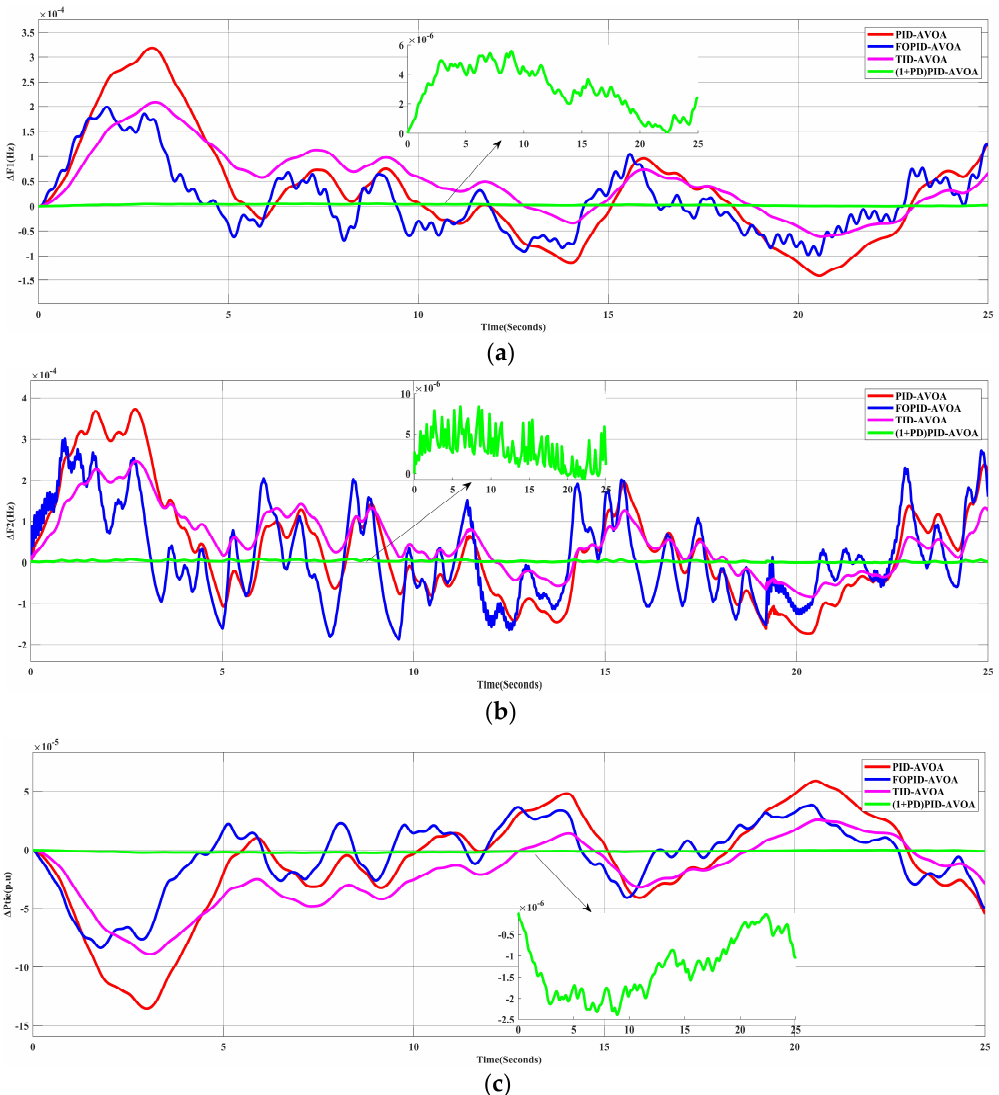
Figure 11. System responses under wind power generation at Area-2: ( a ) Δ F 1 , ( b ) Δ F 2 and ( c ) Δ P tie .